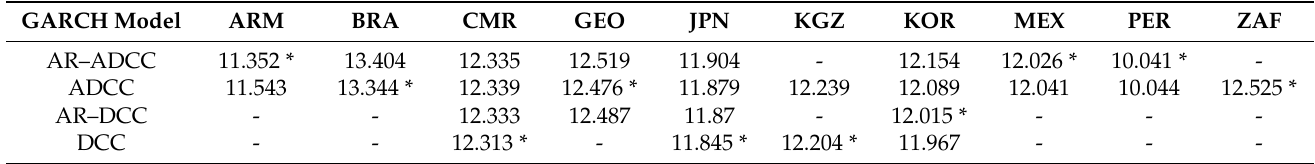
Table 5. The model selection of four specifications for DCC GARCH models.